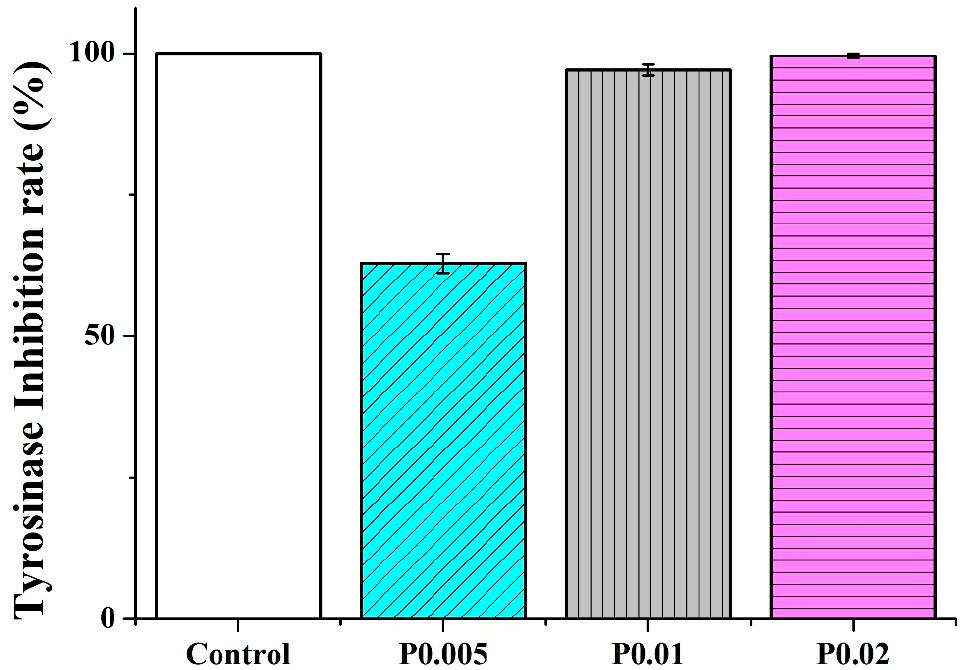
Figure 8. Tyrosinase inhibition rate of nanofiber membranes as related to the P. emblica content.